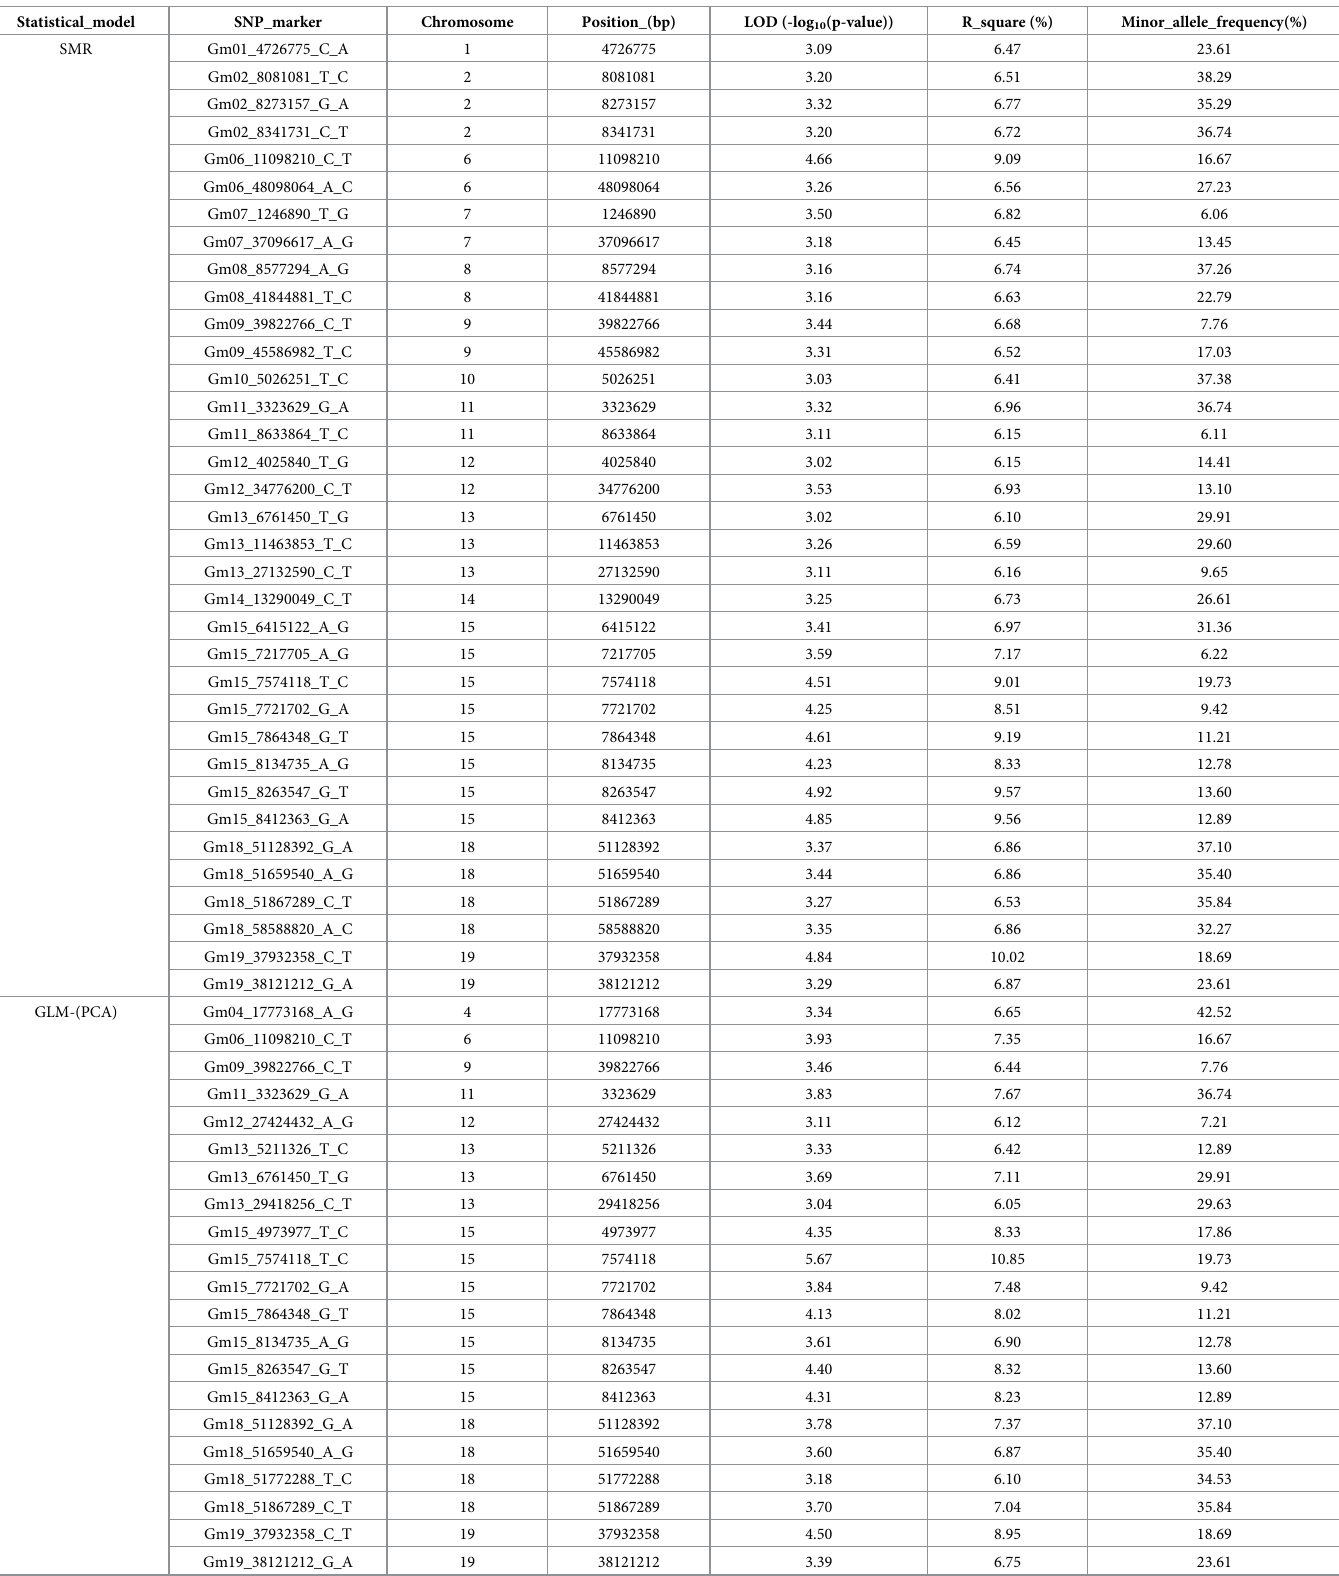
Table 3. Significant SNPs (LOD > 3.00) associated with tolerance to biomass reduction under SCN infestation using a Single Marker Regression (SMR), Generalized Linear Model_PCA (GLM_(PCA)), and Mixed Liner Model_PCA_K(MLM_(PCA+K))